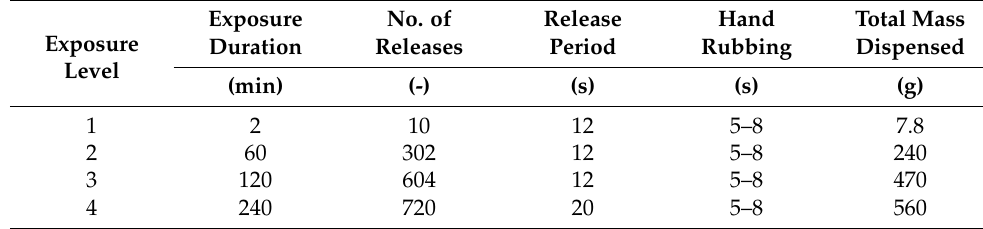
Table 5. Test procedure settings for gel hand sanitizer